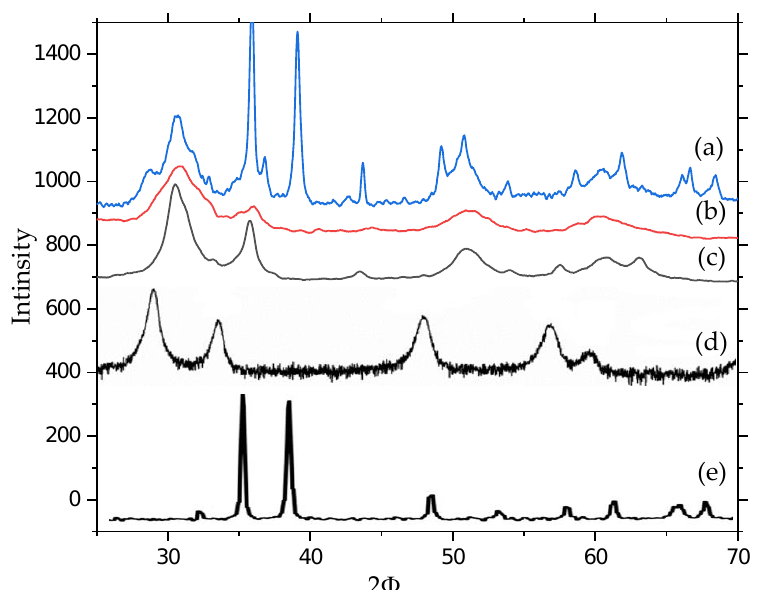
Figure 1. Powder x-ray pattern of (a) CuZr, (b) MnZr, (c) FeZr, (d) La 2 Zr 2 O 7 (ICDD code 00-017-0450), and (e) CuO (ICDD code 00-001-1117).